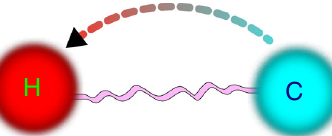
Fig. 2 Anomalous heat fl ows. In the presence of correlations, spontaneous heat fl ows from cold to hot baths are possible 26 . This is an apparent violation of second law, if one ignores the work potential stored in